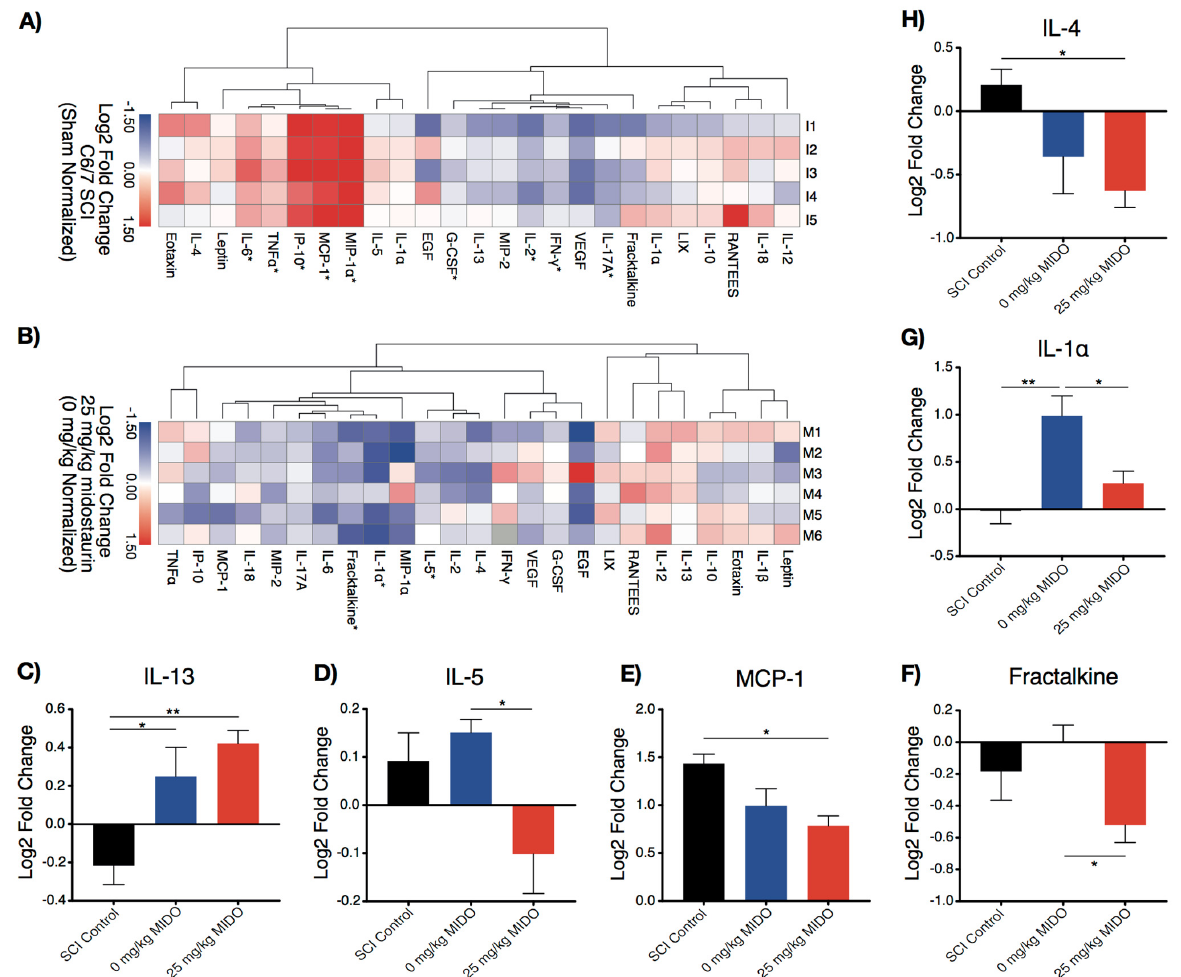
Figure 2. The local inflammatory response at 24 h post-operation in the laminectomized sham ( n = 6), C6/7 SCI control ( n = 5), 0 mg/kg midostaurin ( n = 6), and 25 mg/kg midostaurin ( n = 6) cohorts. ( A , B ) Hierarchical clustering was performed based on cosine similarity. Statistically significant changes are illustrated with an asterisk (*), as determined by a t-test using FDR according to the two-stage linear set-up procedure of Benjamini, Krieger, and Yekutieli to correct for multiple comparisons. ( A ) Heat map illustrates log 2 fold change in the C6/7 SCI control cohort relative to shams. ( B ) Heat map illustrates log 2 fold change in the 25 mg/kg midostaurin cohort compared to the 0 mg/kg midostaurin cohort. ( C – H ) Statistically significant expressions in the 25 mg/kg midostaurin cohort compared to either the 0 mg/kg midostaurin or C6/7 SCI control cohorts (determined by one-way ANOVA using Holm–Sidak for multiple comparisons; demonstrated in log 2 sham-normalized fold change ± SEM; *: p < 0.05; **: p <